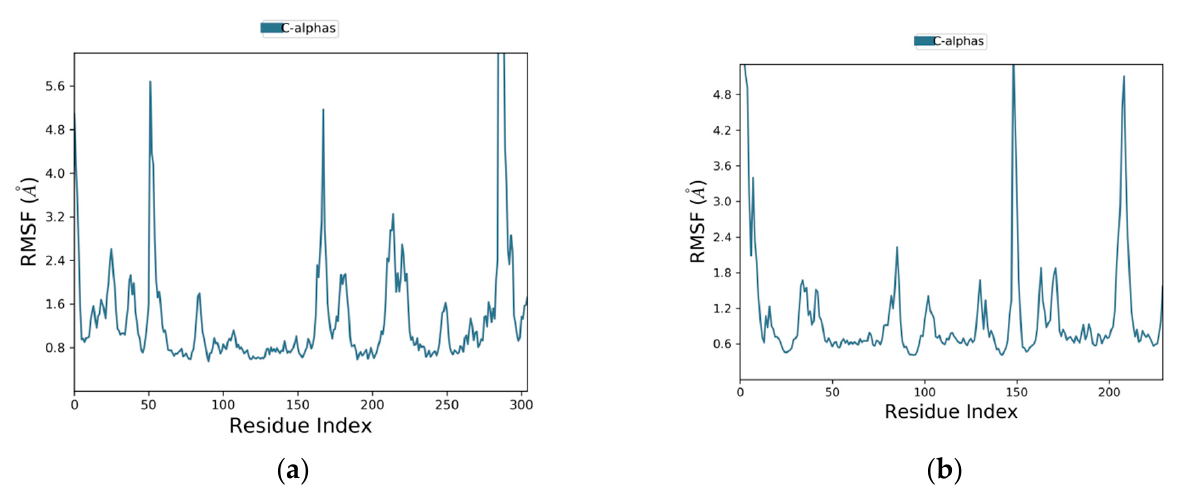
Figure 6. The plots of residue wise root mean square fluctuation (RMSF). ( a ) RMSF plot of EGFR and ( b ) RMSF plot of caspase-9 as receptor proteins.